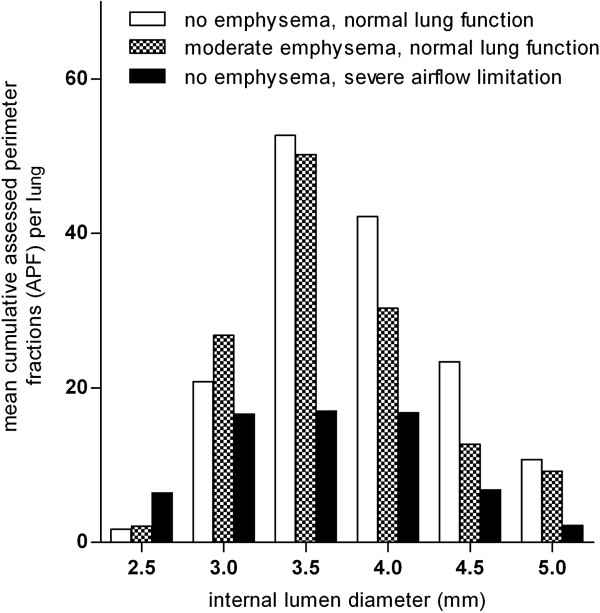
Determination of the optimal airway size. Mean cumulative assessed perimeter fractions in the total lung, for different groups of patients at different internal airway lumen diameters. APF was measured on low-dose CT of 20 selected NELSON subjects divided into 3 groups: subjects without emphysema and with normal lung function (n = 8, perc15 > −910 and FEV1/FVC > 85 %), with moderate emphysema and normal lung function (n = 4, -940 < perc15 < −960 and FEV1/FVC > 70 %) and without emphysema and having severe airflow limitation (n = 8, perc15 > −920 and FEV1/FVC < 50 %), in airways with a lumen diameter of 2.5, 3.0, 3.5, 4.0, 4.5 and 5.0 mm (± 0.25 mm).